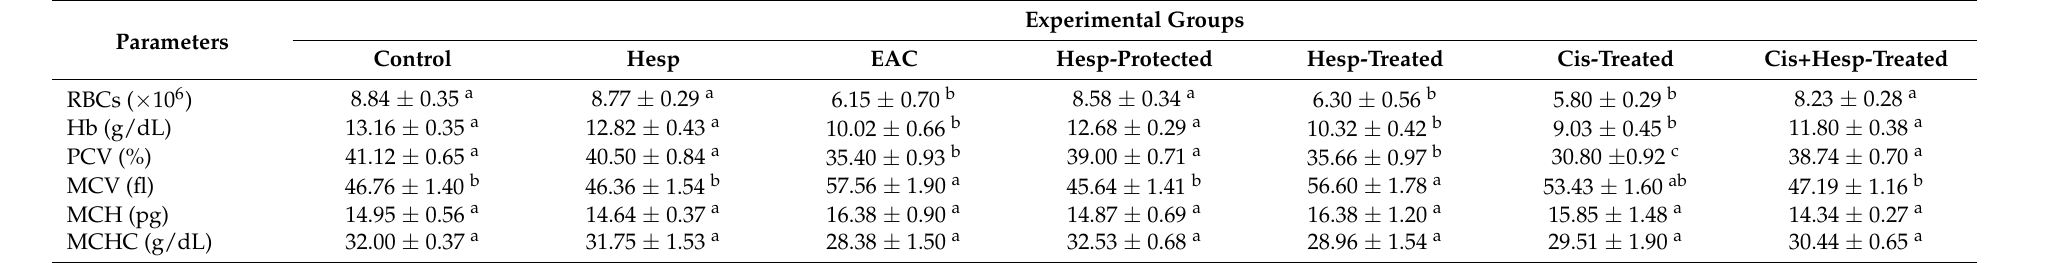
Table 2. Effect of hesperidin and/or cisplatin on erythrogram parameters of EAC-bearing mice.